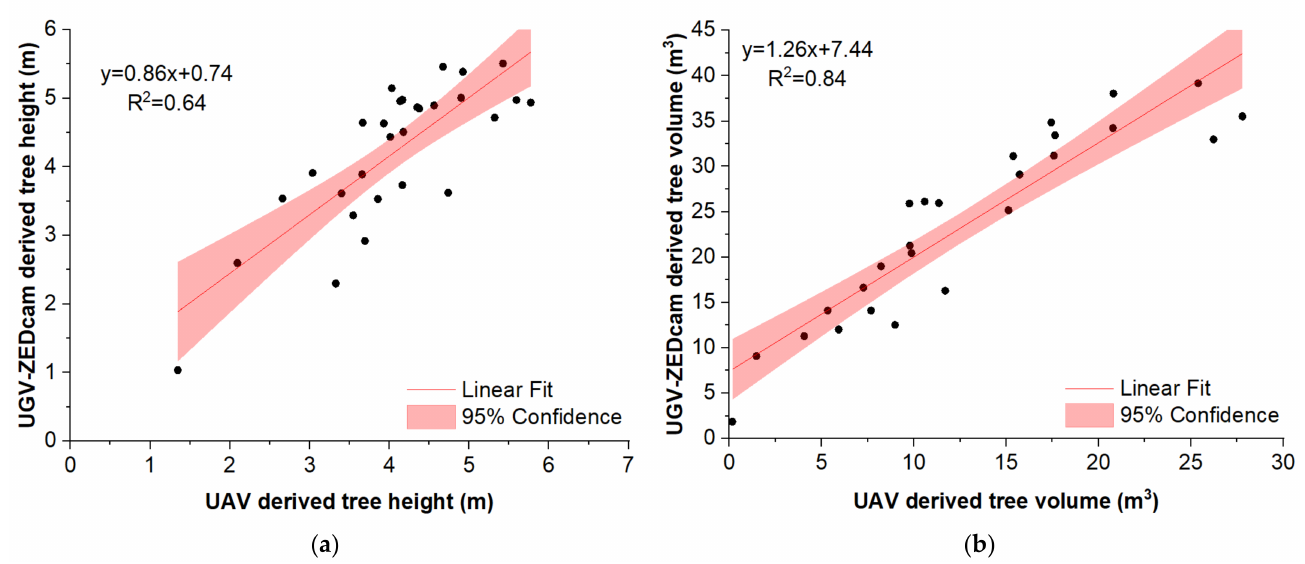
Figure 7. Comparison between the trees dimension measurements; trees height ( a ) and trees volume ( b ), derived by using the two sensing methods; the UAV aerial-based system and the UGV-ZED depth camera ground-based system; the colored areas show the lower and upper confidence (95%) limits.